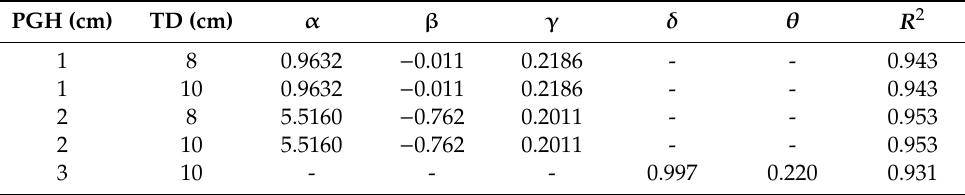
Table 4. Summary of the model